Question: In one sentence, what is this figure communicating?
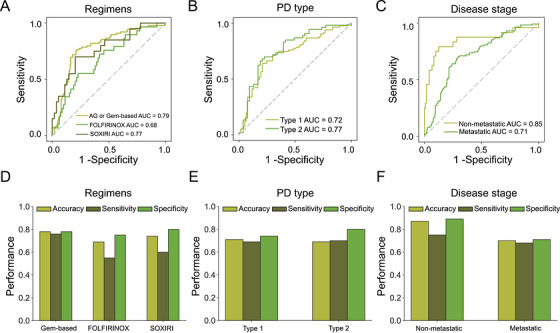
Answer: Performance of the prediction model across different clinical subgroups. (A–C) ROC curves of the prediction model in subgroups stratified by treatment regimen, progression type, and baseline disease stage. (D–F) Bar charts showing accuracy, sensitivity, and specificity of the prediction model in subgroups stratified by treatment regimen, progression type, and disease stage.